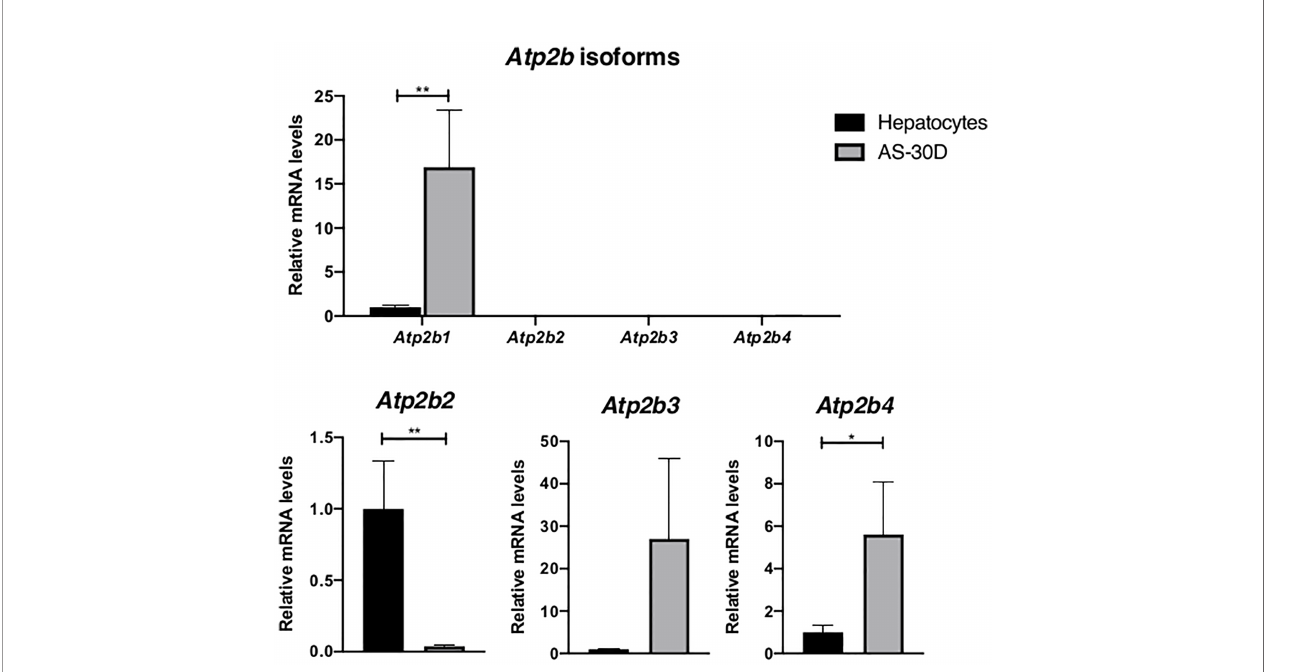
FIGURE 6 | Expression of genes encoding for the plasma membrane Ca 2+ -ATPases ( Atp2b1-Atp2b4 ) in rat hepatocytes and AS-30D cells. Rat hepatocytes were freshly isolated and AS-30D samples were obtained from cells from the ascitic fl uid of experimental rats. Data represented as mean ± SD. *p-values ≤ 0.05; **p ≤